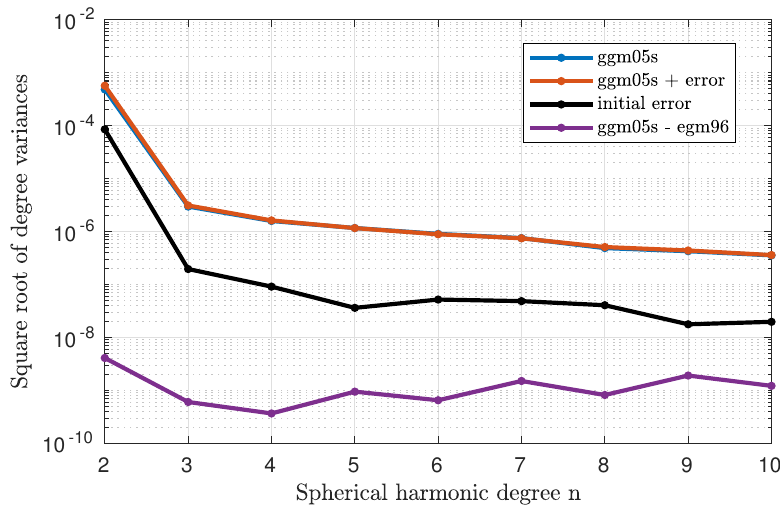
Figure 1. Square root of degree variances from true gravity field (GGM05S), with which observations were simulated, initial gravity field for the estimation process, and the difference between both fields. As comparison the difference between GGM05S and EGM96 is also shown.